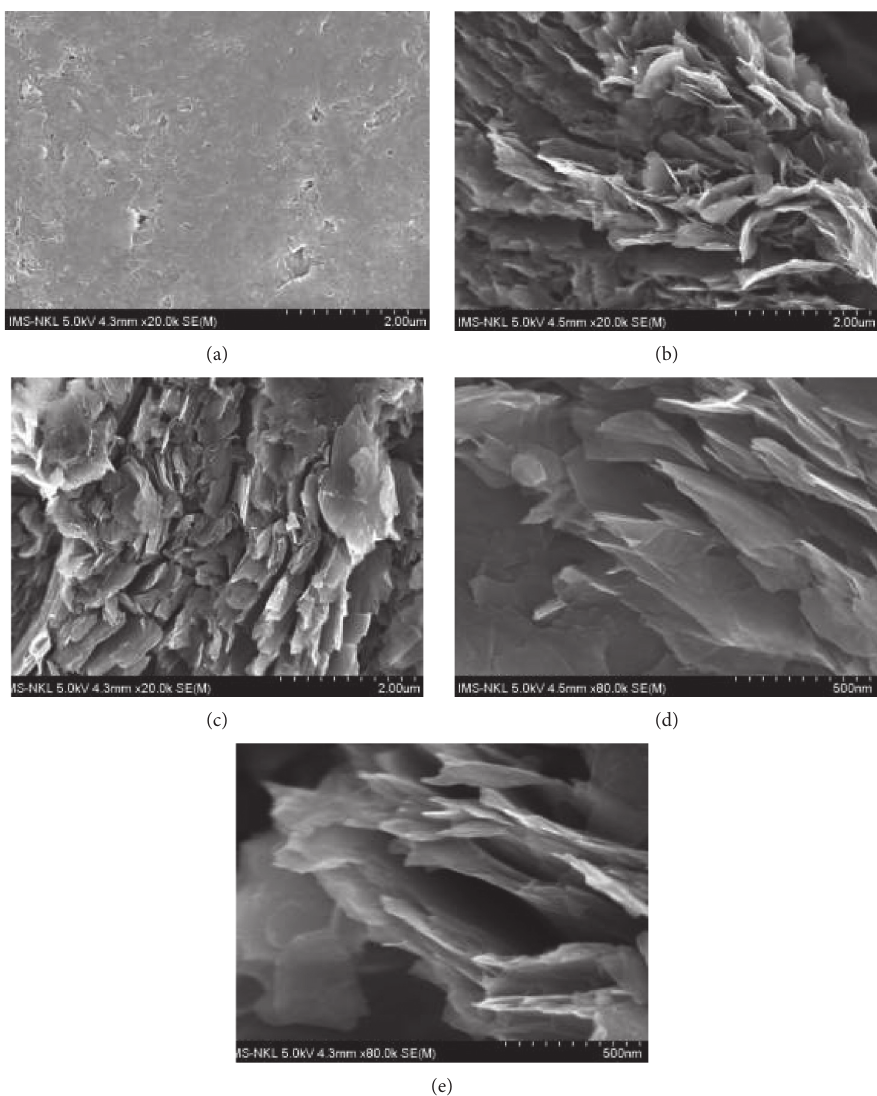
Figure 1: SEM images of graphite electrode (a), graphite oxide nanosheet electrode (b, d), and reduced graphite oxide nanosheet electrode (c, e) at different